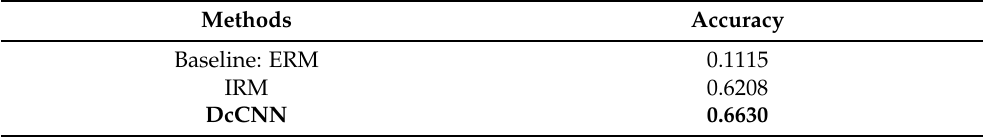
Table 5. Comparison of accuracies for reversed color-biased MNIST dataset among different methods. Results are calculated on testing